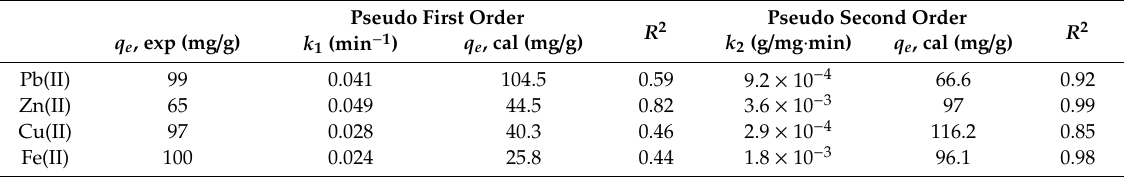
Table 1. Parameters for the kinetics of the adsorption of Pb(II), Zn(II), Cu(II), and Fe(II) onto RC-MWS.